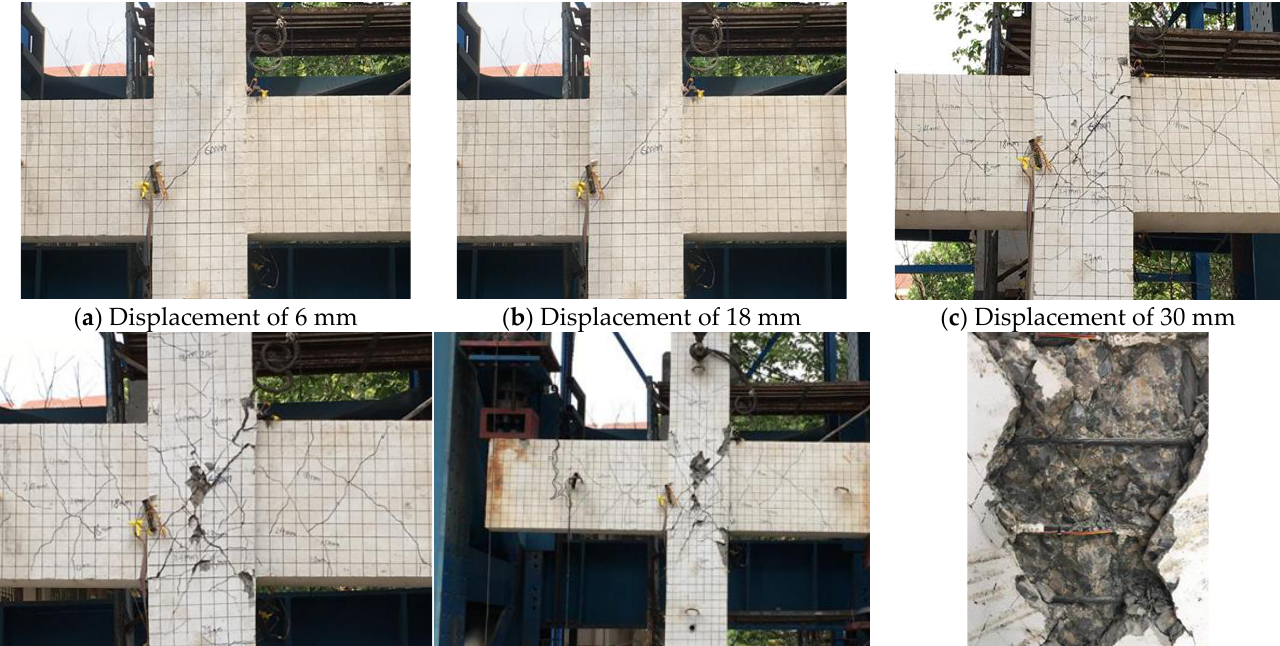
Figure 11. Crack development and failure of specimen ZJ-1.